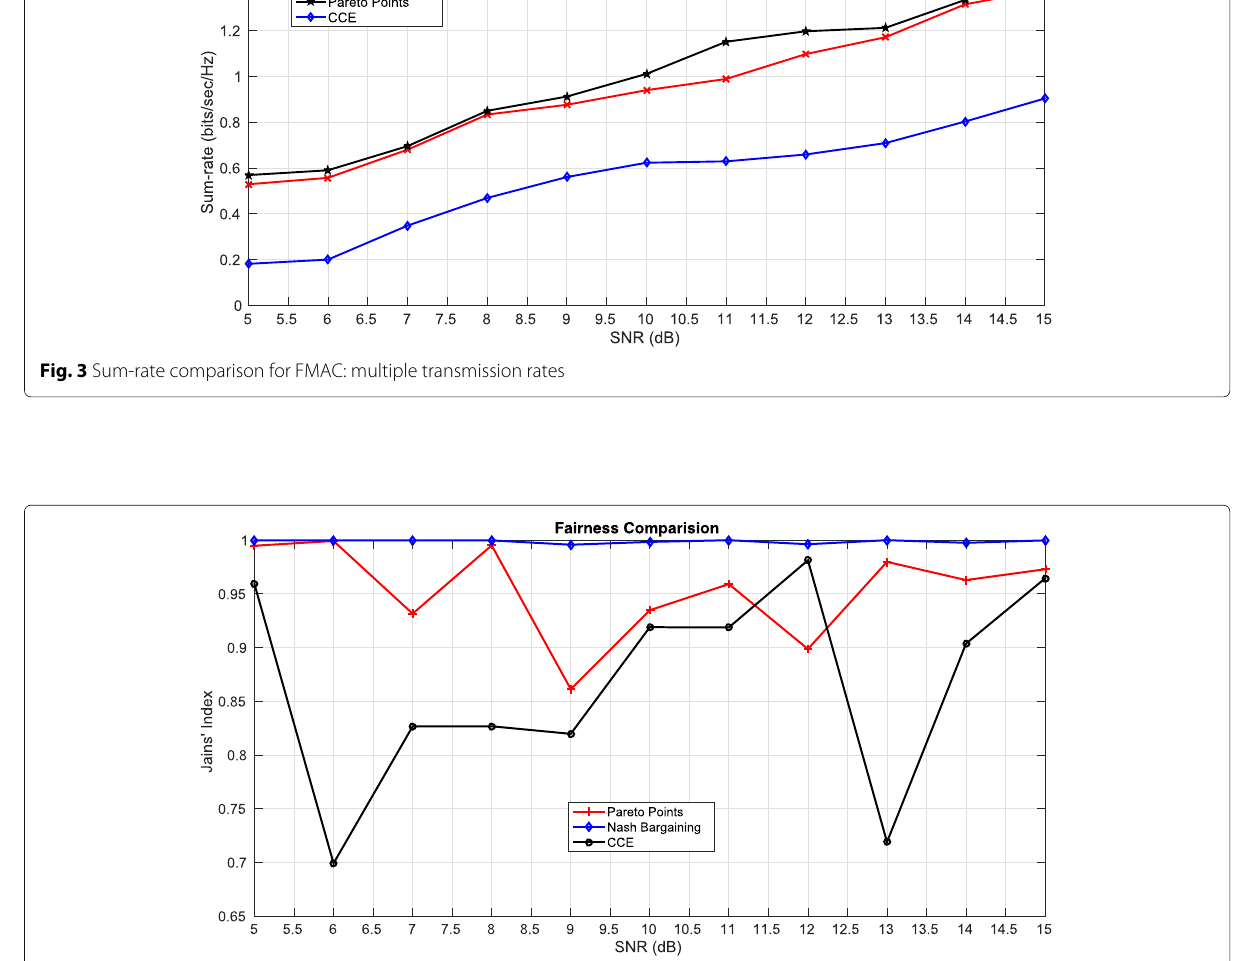
Fig. 4 Fairness comparison for F-MAC: multiple transmission